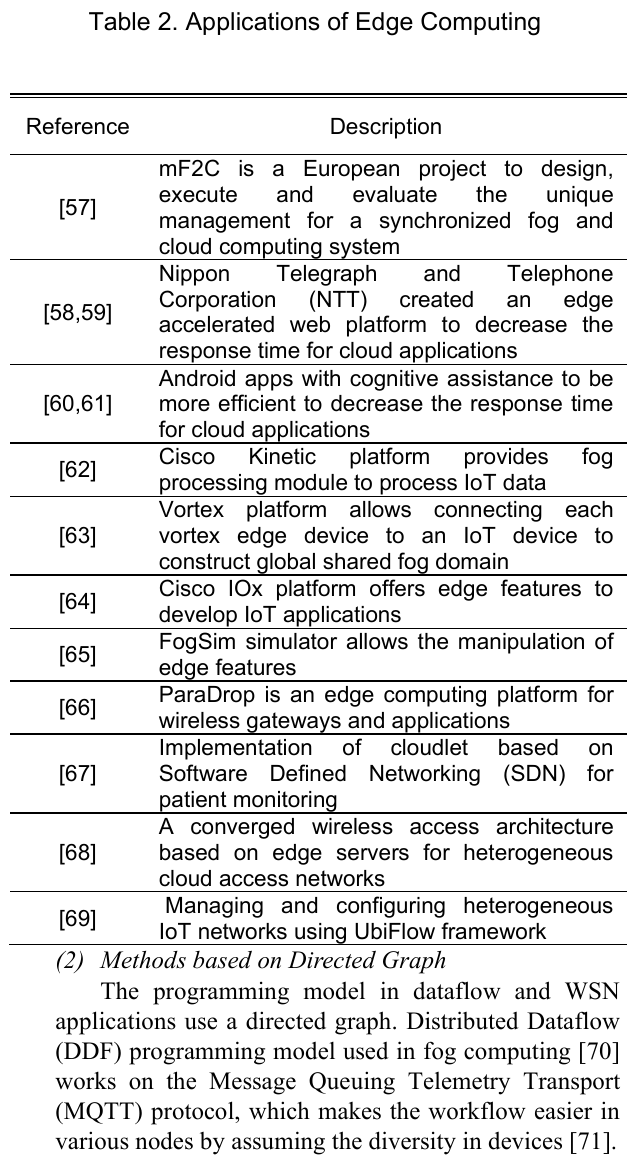
Table 2. Applications of Edge